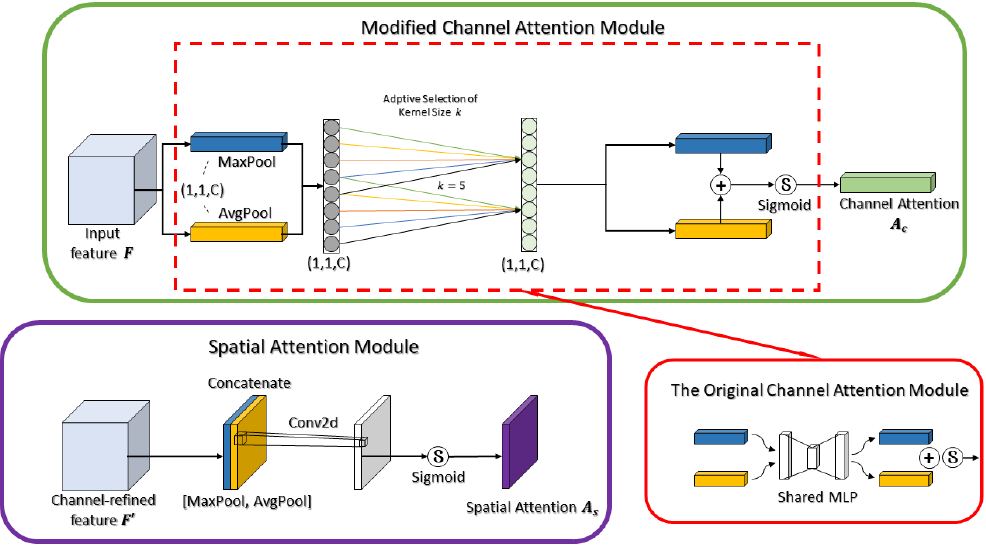
Figure 3. Improved Channel Attention Module and Spatial Attention Module.